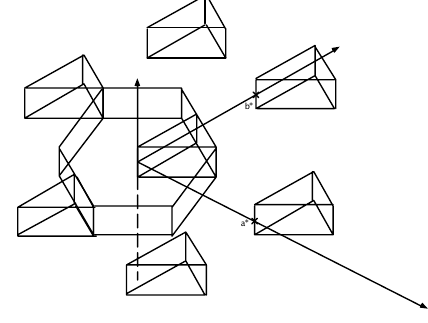
Figure 3 . The reciprocal space around the first B.Z. The cross points ( × ) denote reciprocal lattice